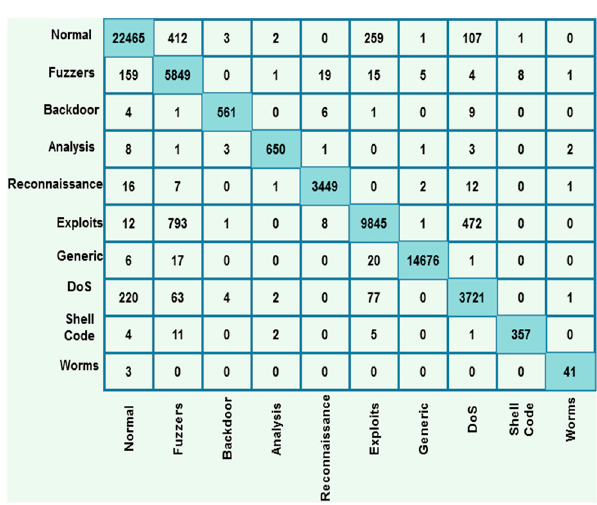
Figure 14. Confusion matrix for dataset 3.